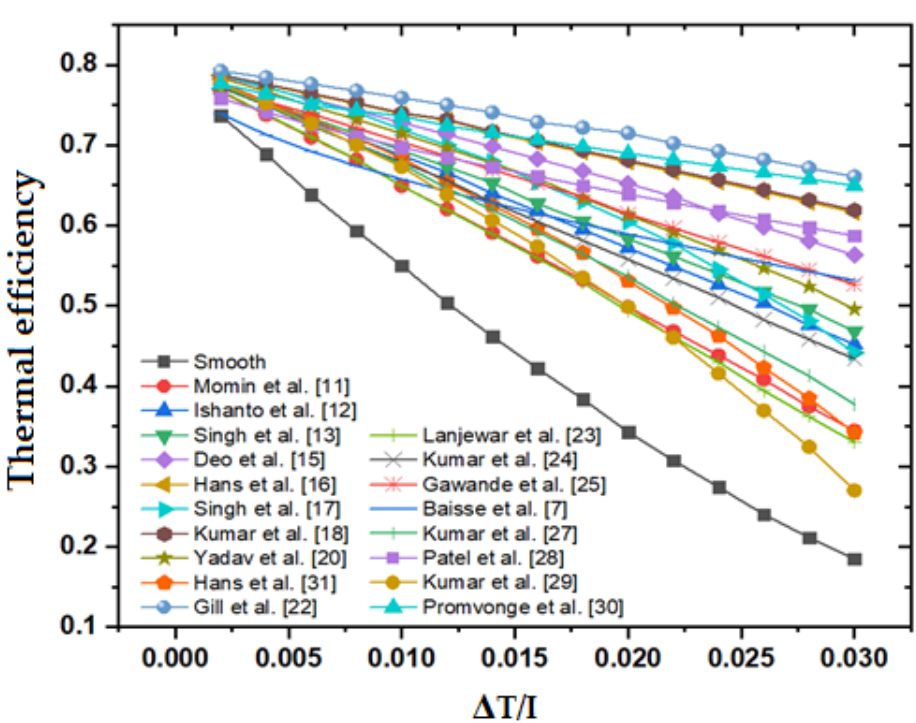
Figure 4. Thermal efficiency of the roughened duct with respect to Δ T/I.